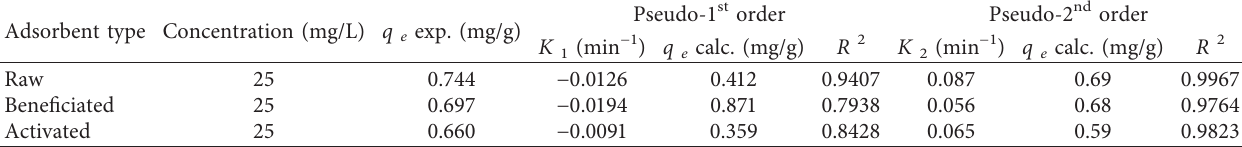
Table 2: Kinetic parameters for MB adsorption on raw, beneficiated, and activated